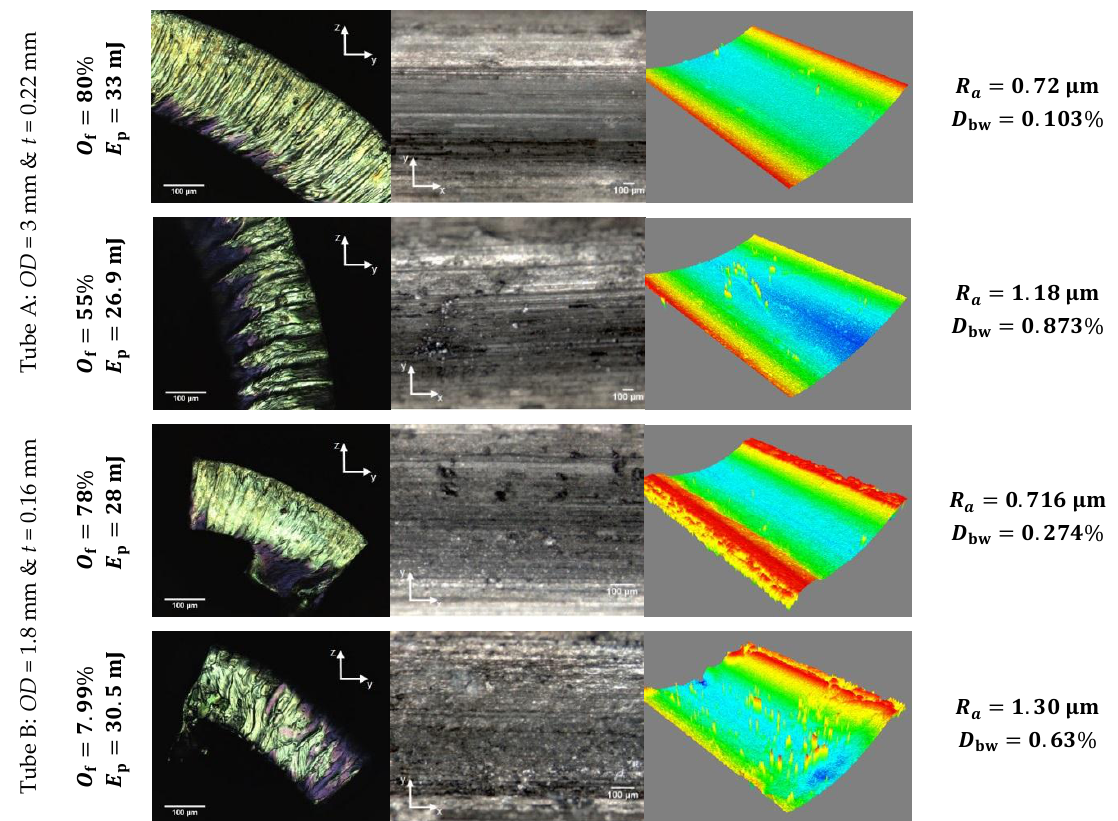
Figure 8. Selected process conditions and corresponding surface roughness and back-wall dross—experimentation without gas blowing through the tube.